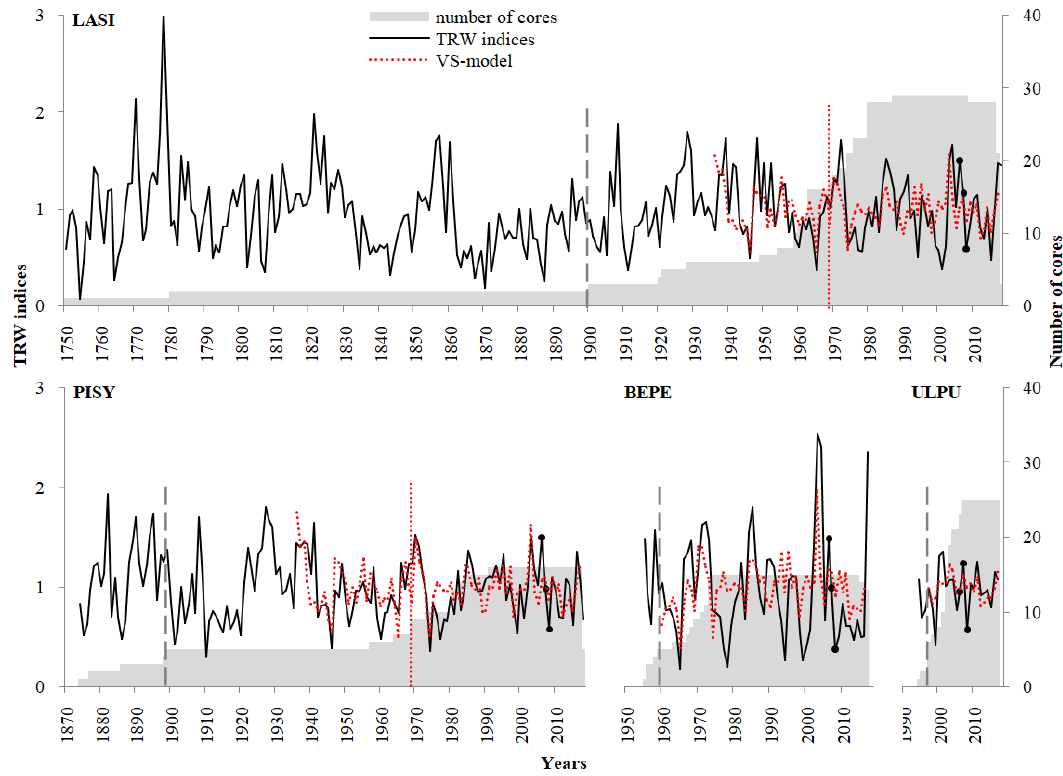
Figure 4. Tree ring width (TRW) chronologies of Siberian larch (LASI), Scots pine (PISY), silver birch (BEPE), and Siberian elm (ULPU). Black solid lines represent the standard indexed chronologies; the shaded area represents the number of cores for each year; the red dotted lines represent the chronologies simulated with the Vaganov–Shashkin (VS)-model. For each chronology, the beginning of the period is when EPS > 0.85, which is marked with vertical dashed line; for conifers, the verification and calibration periods of the modeling are divided by the vertical dotted line. The years of the modeled growth rates (i.e., 2006–2008) are marked by black dots on the actual chronologies.